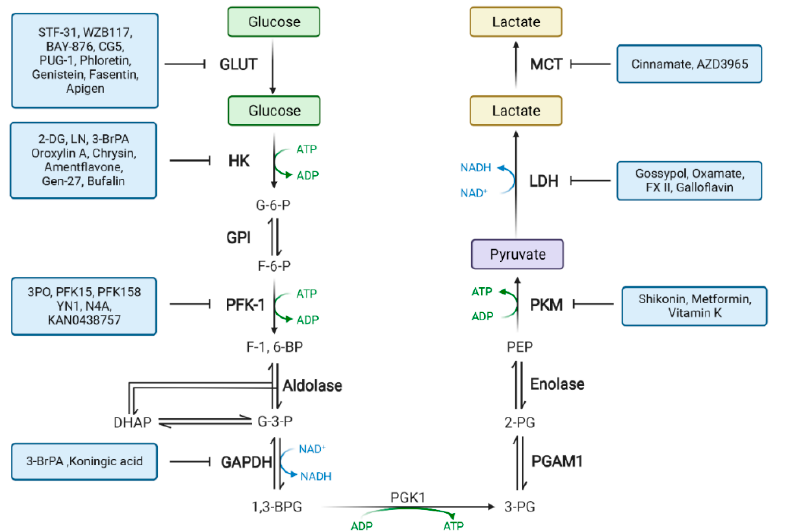
Figure 2. Drugs targeting glucose metabolism in cancer cells. Reprogramming of glucose metabolism provides many potential targets for cancer therapy. Created with BioRender.com (accessed on 22 August 2022). Abbreviations: 1,3 BPG, 1,3-bisphosphoglycerate; 2-PG, 2-phosphoglycerate; 3-PG, 3-phosphoglycerate; ADP, adenosine diphosphate; ALDO, aldolase; ATP, adenosine triphosphate; DHAP, dihydroxyacetone-phosphate; ENO, enolase; F-1,6-BP, fructose-1,6-bisphosphate; F-2,6-BP, fructose-2,6-bisphosphate; F-6-P, fructose-6-phosphate; G-3-P, glyceraldehyde-3-phosphate; G-6-P, glucose-6-phosphate; HK, hexokinase; LDH, lactate dehydrogenase; GAPDH, glyceraldehyde-3- phosphate dehydrogenase; GLUT, glucose transporter; GPI, glucose-6-phosphate isomerase; MCT, monocarboxylate transporter; PEP, phosphoenolpyruvate; PFK1, phosphofructokinase-1; PFKFB, 6- phosphofructo 2-kinase/fructose-2,6-bisphosphatase; PGAM1, phosphoglycerate mutase 1; PGK1, phosphoglycerate kinase 1; PK, pyruvate kinase; TPI, triosephosphate isomerase.